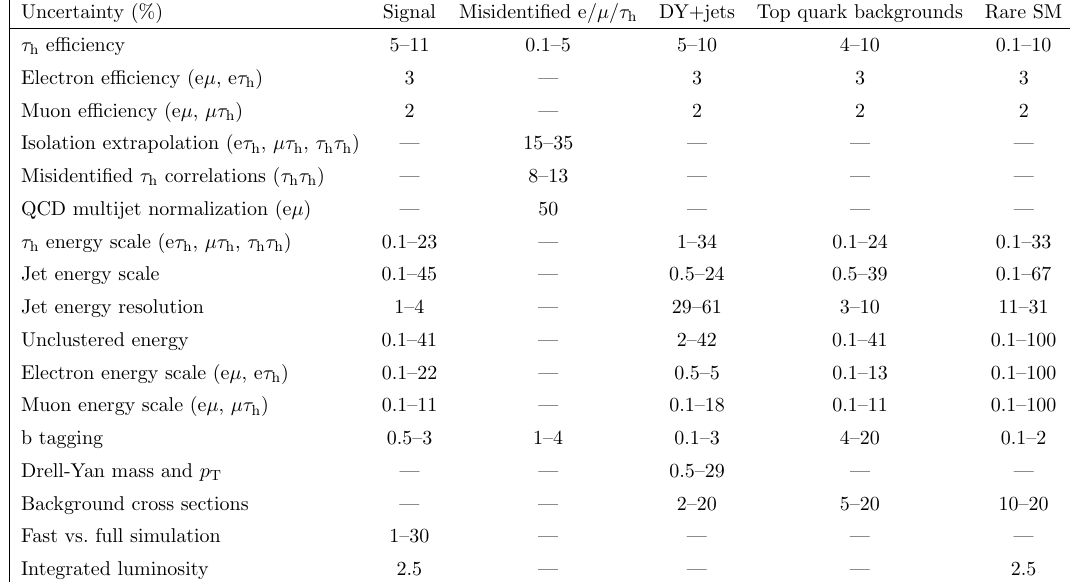
Table 9. Systematic uncertainties in the analysis for the signal models and the di(cid:11)erent SM background predictions. The uncertainty values are evaluated separately for each signal model and mass hypothesis studied and are listed as percentages.